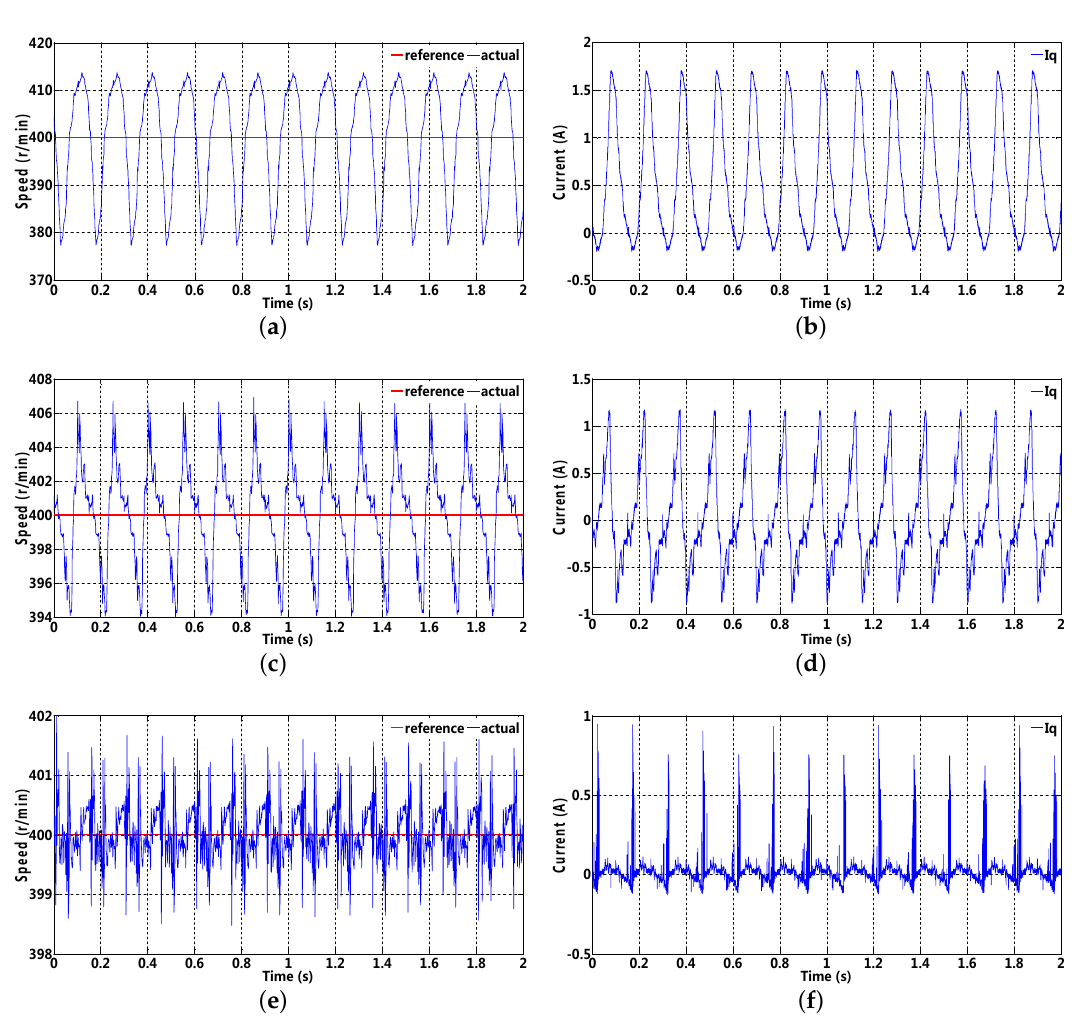
Figure 18. Speed and corresponding q -axis current based on the original PI controller (without disturbance compensation), DOB and APDOB (20 Hz): ( a , b ) speed and corresponding q -axis current with the original PI controller; ( c , d ) speed and corresponding q -axis current with DOB; ( e , f ) speed and corresponding q -axis current with